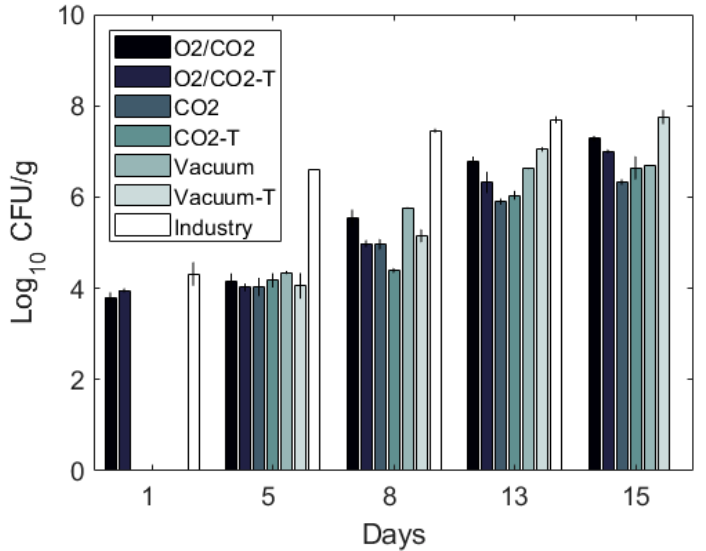
Figure 2. Total bacterial count (log10 CFU/g) (mean ± standard error of the mean, SEM) per packaging method of cod loins during storage (2 °C). The “CO 2 ” samples are packaged with 60% CO 2 , 40% N 2 and a CO 2 emitter, and “O 2 /CO 2 ” is packaged with 60% CO 2 and 40% O 2 . “Industry” samples and “Vacuum” samples are packaged with vacuum. The samples marked with “T” are thawed samples, and the “CO 2 ”, “O 2 /CO 2 ”, “Vacuum” and “Industry” are fresh packaged fillets.